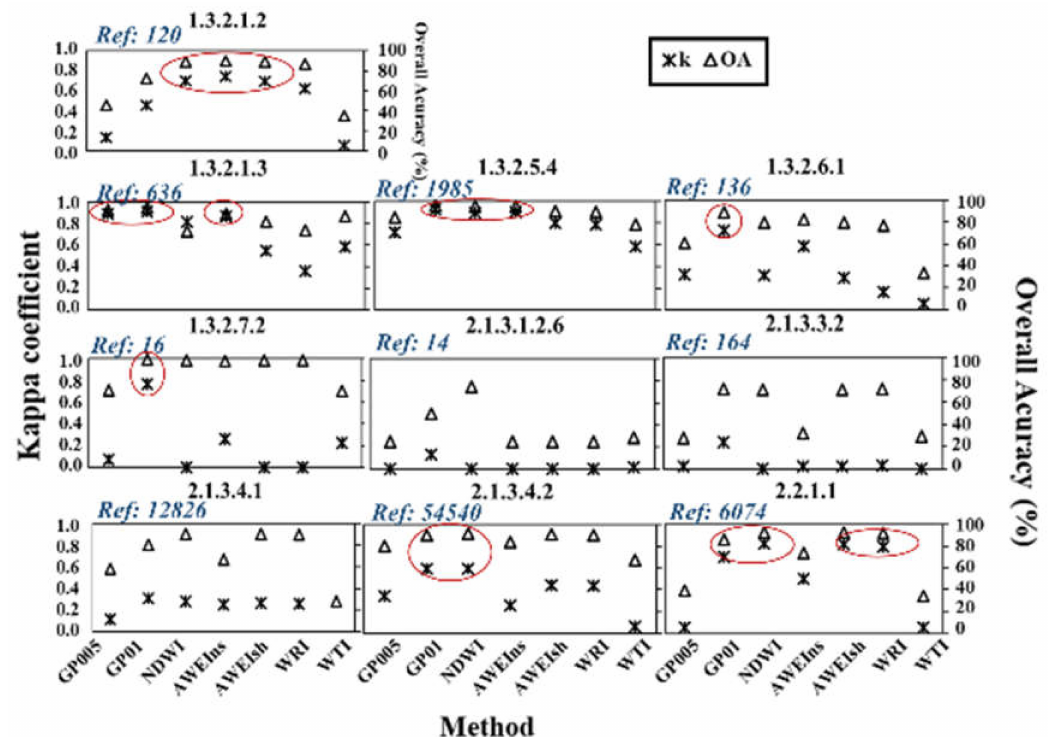
Figure 5. Kappa coefficient (crosses) and overall relative accuracy (triangles) for the different methods tested and the different lake/wetland types as listed in Table 1, for the Sentinel-2 imagery. In blue is indicated the number of reference water pixels and the best results for each lake/wetland type are marked in